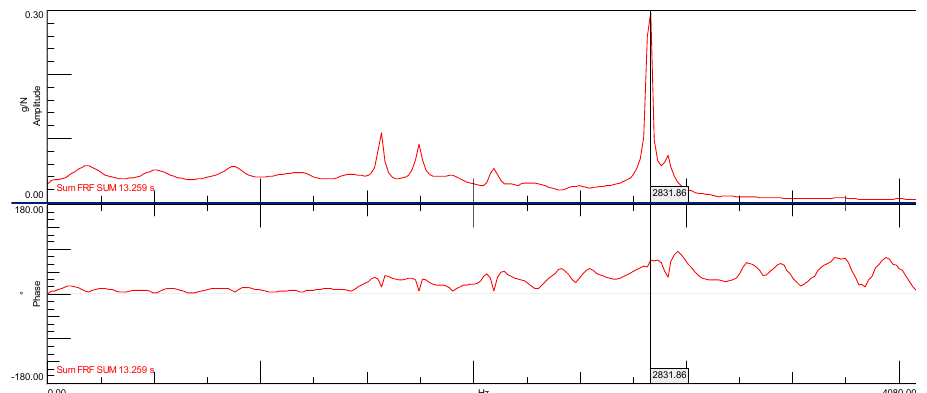
Figure 19. Spectral function of the FRF transition created with the use of the SUM indicator for the ordinary concrete cube.